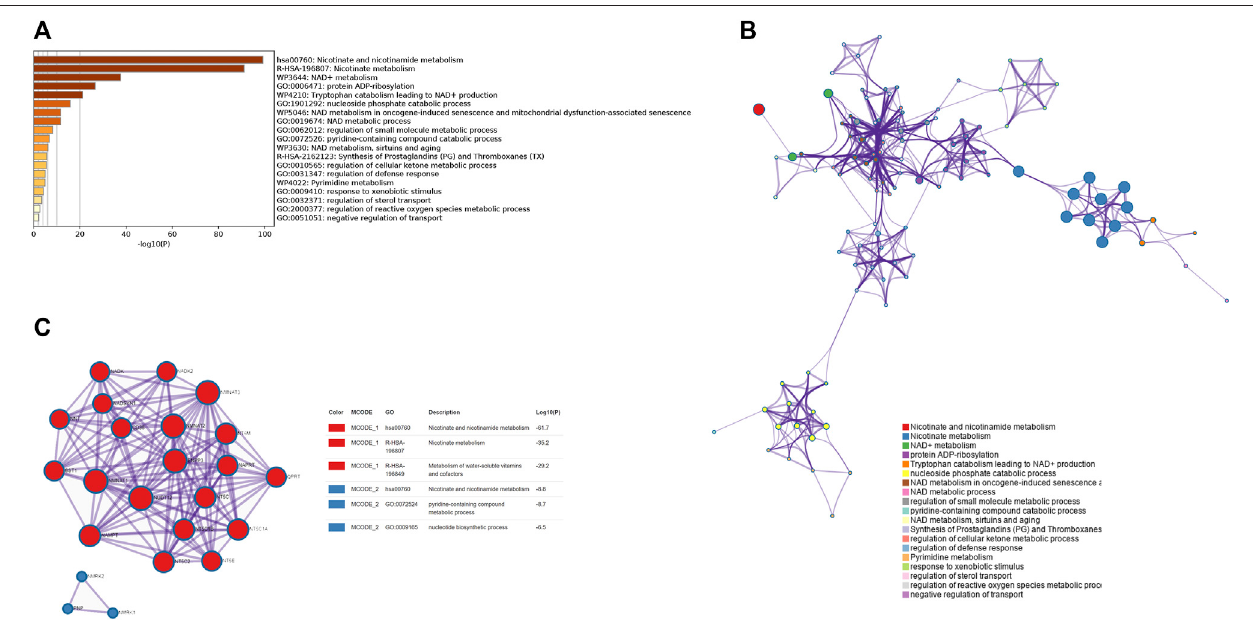
FIGURE 2 | Functional enrichment of NMRGs and visualization of interactome analysis results. (A) Metascape enrichment analysis for the NMRGs. (B) Metascape enrichmentnetworkvisualizationshowingtheintra-clusterandinter-cluster similaritiesofenrichedterms. (C) Metascapevisualizationoftheinteractomenetworkformed by NMRGs candidates, where the MCODE complexes are colored according to their